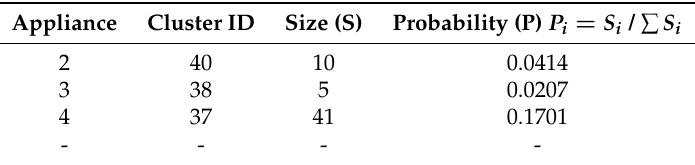
Table 6. Cluster analysis: cluster marginal